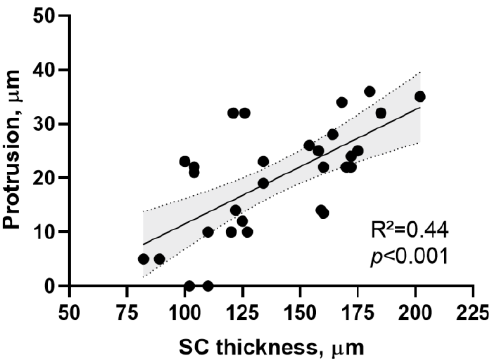
Figure 5. Positive correlation between SC thickness and the height of protrusions (R 2 = 0.49; p < 0.001).